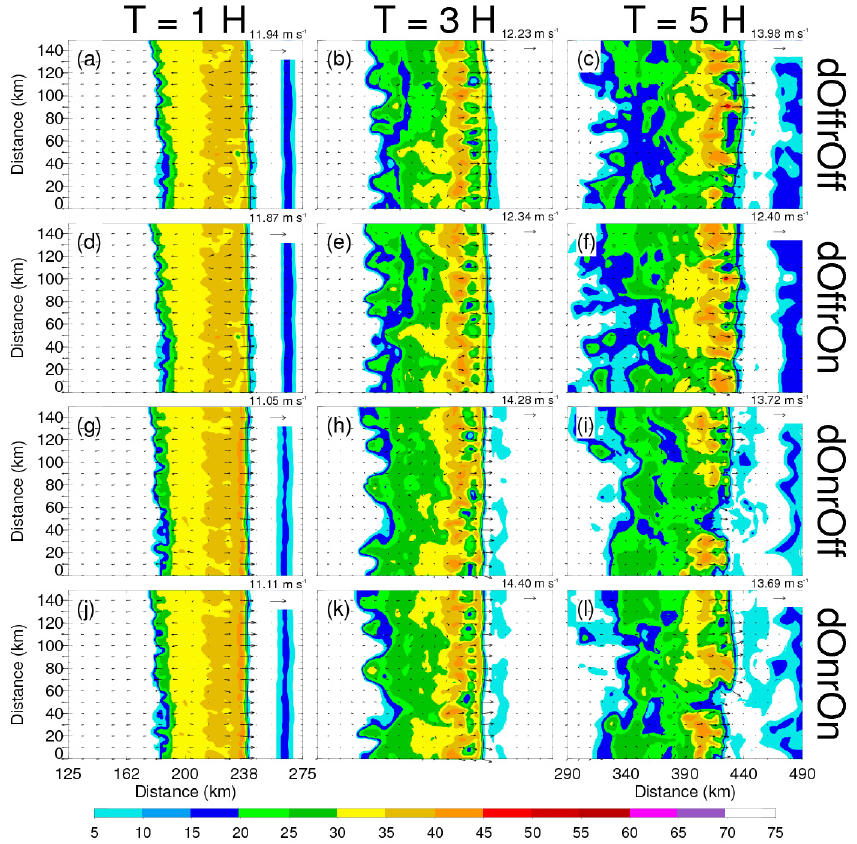
Fig. 3. Simulated base radar reflectivity (dBZ; Matrosov, 1999) of dOffrOff (a–c) , dOffrOn (d–f) , dOnrOff (g–i) , and dOnrOn (j–l) at 1kma.g.l. for the following: (a, d, g, j) T = 1h; (b, e, h, k) T = 3h; and (c, f, i, l) T = 5h into the sensitivity simulations. The surface winds are shown (vectors) along with the maximum surface wind reference vector in the upper-right corner for each image.